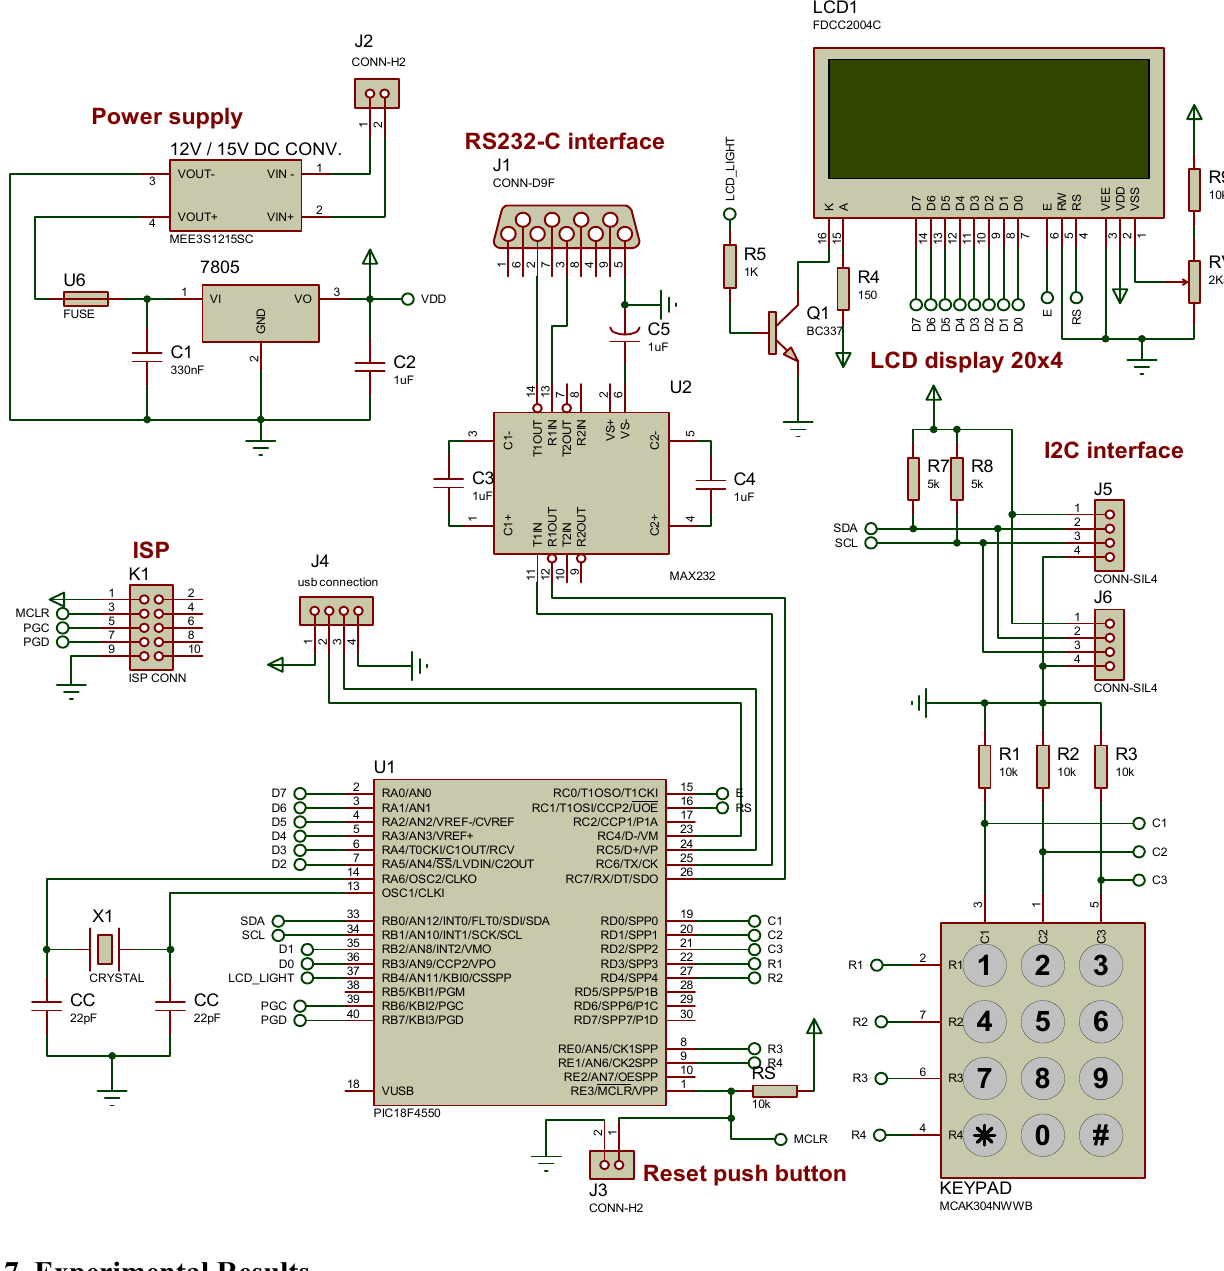
Figure 24. Master control ISIS model: microcontroller, RS232 interface, I2C interface, power supply, user interface keypad and display